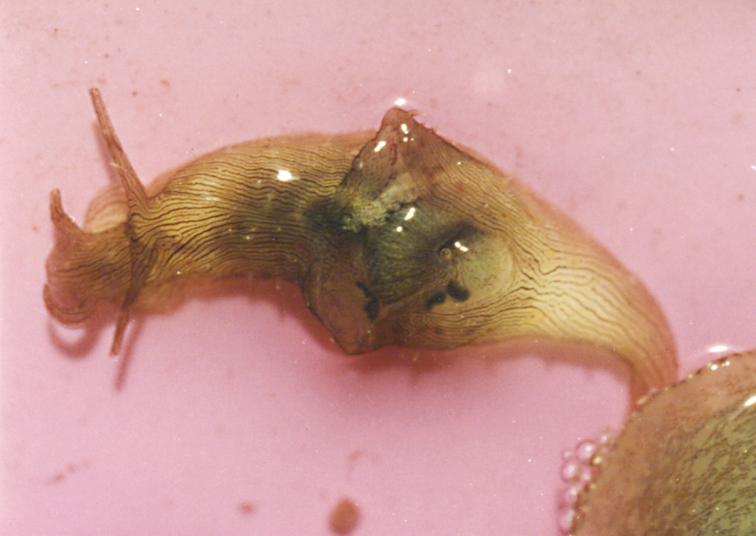
Stylocheilus longicauda form striata, 10–50 mm pres., Zanzibar, photo: MD Richmond.